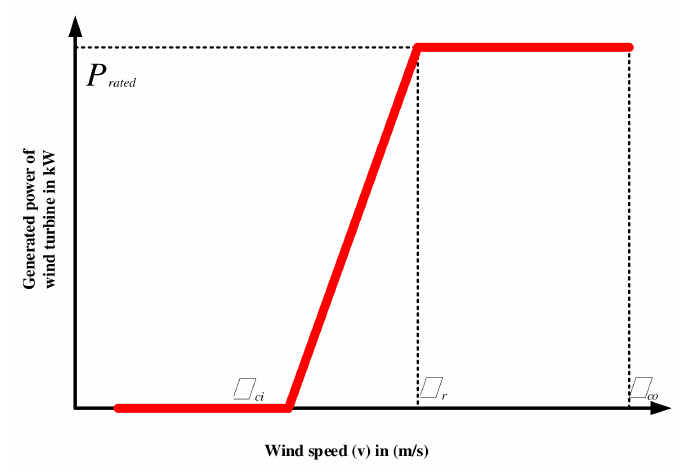
Figure 1. WTs speed power